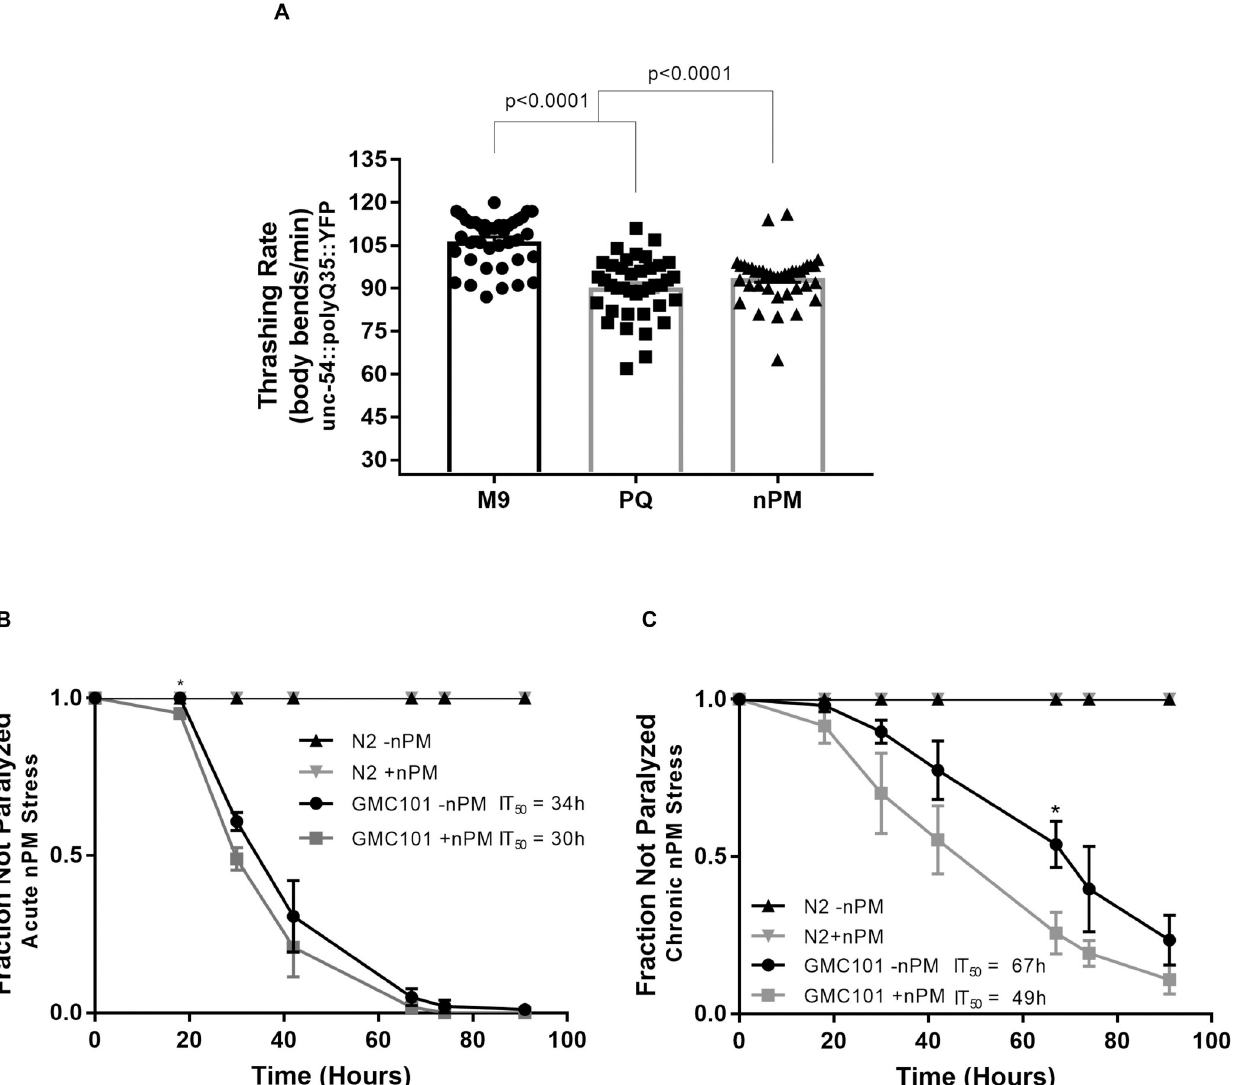
Fig 2. nPM is associated with increased toxicity. A) Toxicity was measured as a function of thrashing rate in liquid. C . elegans expressing polyQ35::YFP in body wall muscle cells were exposed for 3d to nanoparticulate matter (nPM), the oxidant paraquat (PQ), or mock exposed to vehicle (M9) starting at the L4 stage. Bars represent the average number of body bends per minute. The experiment was performed in biological triplicate with all individual measurements indicated ( ⚫ , M9; ◼ , PQ; ▲ , nPM). Error bars represent the standard error of the mean (SEM) and P-values are the results of pairwise T-tests with Welch’s correction. B and C) L4 stage adult wild type animals (N2) or those expressing amyloid beta (A β ) in body wall muscle cells (strain GM101) were exposed to nPM, or M9 as a control, for 1h (B) or 72h (C) and then transferred to NGM plates seeded with OP50. Paralysis was monitored from that point forward for 96hrs at the restrictive temperature of 25˚C. Data represent averages of biological triplicates, error bars represent the standard error of the mean. � represents p < 0.05 for pairwise T-tests, which were preformed to determine statistically significant differences in paralysis between +/-nPM at each timepoint individually. IT 50 refers to time to 50% paralysis for GMC101 animals exposed to +/- nPM as determined following regression analysis. Differences between IT 50 for +/-chronic nPM exposure (C) are statistically significant (p =